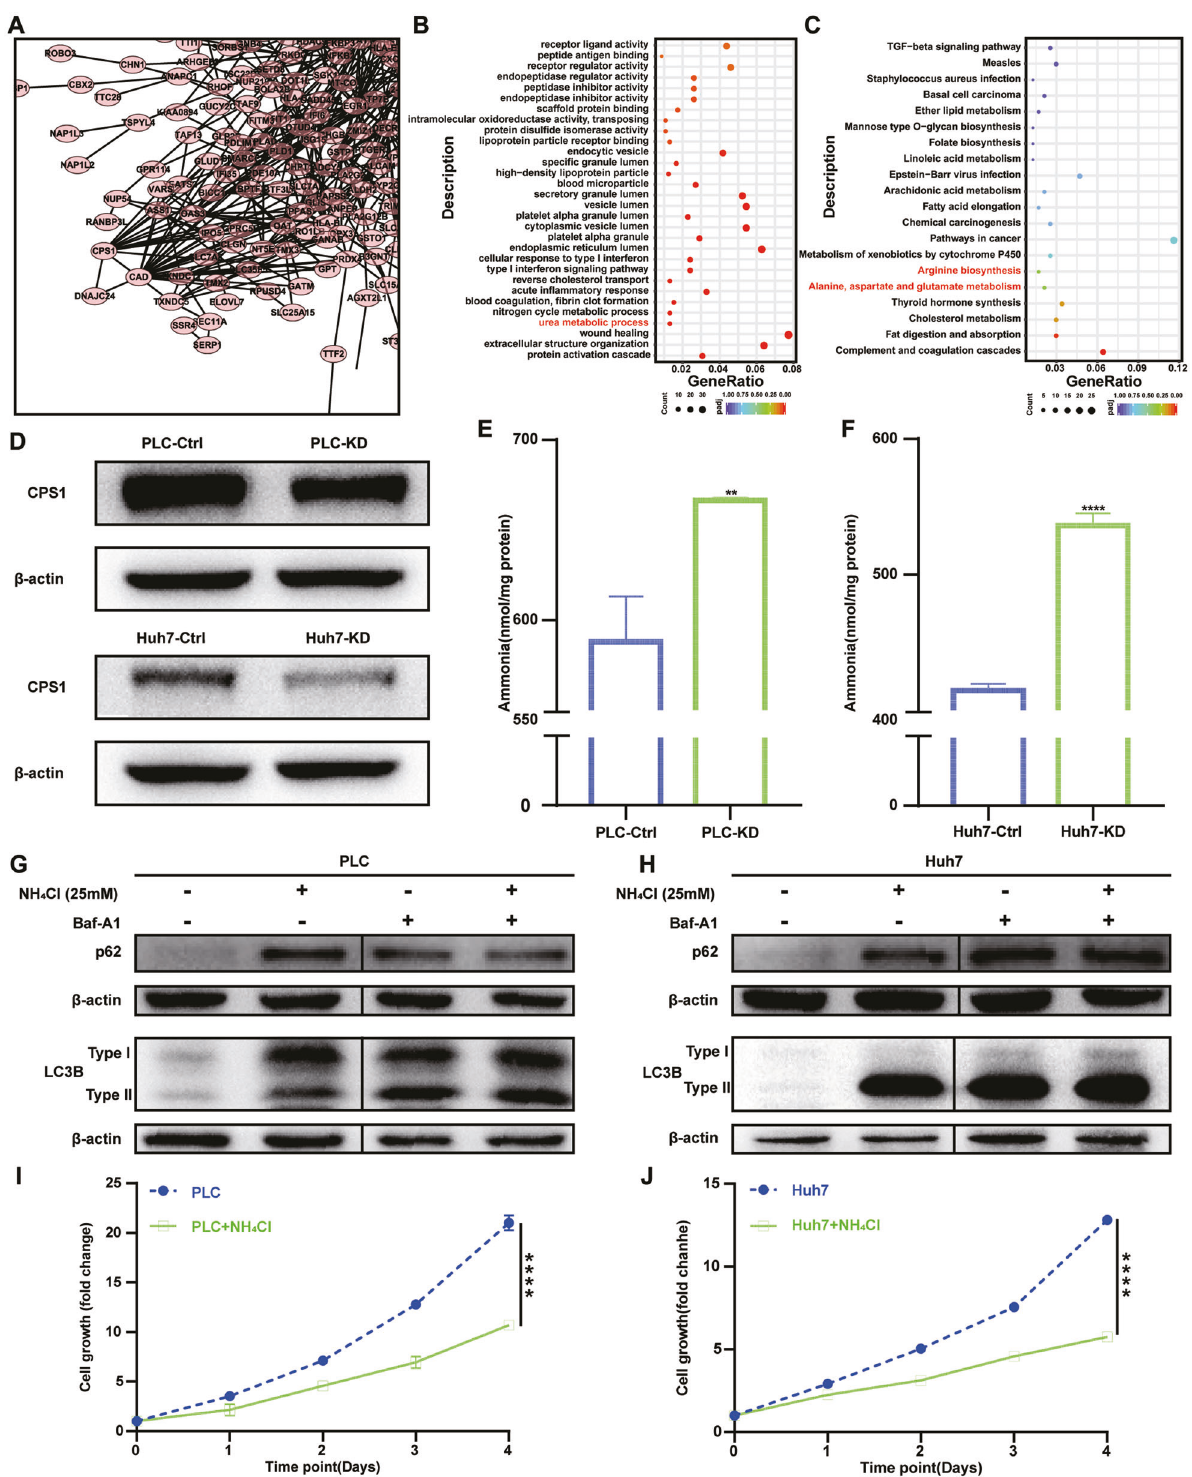
Fig. 6 DNAJC24 knockdown inhibits HCC cells proliferation and autophagy by affecting the metabolism of ammonia. A Interactions in the STRING protein interaction database were used to analyze DEGs interaction networks. B , C GO functional enrichment analysis ( B ) and KEGG pathway enrichment analysis ( C ) of DEGs was performed to identify functionally related gene pathways. D Western blotting was performed to determine protein levels of CPS1. E , F NH 4 + /NH 3 levels were measured in the PLC-KD ( E ) cells or Huh7-KD ( F ) cells as well as in the corresponding control cells using an ammonia assay kit by spectrophotometric analysis at 570 nm with extrapolation from the standard curve and expressed in nmol/mg protein. G , H NH 4 Cl ( fi nal concentration 25 mM) or/and Ba fi lomycin A1 ( fi nal concentration 400 nM) was added to the culture medium of PLC or Huh7 and incubated for 24h, respectively. Western blotting was performed to determine protein levels of LC3B. I , J CCK-8 cell viability assay analysis of the impact of NH 4 Cl ( fi nal concentration 25 mM) on PLC ( I ) and Huh7 ( J ) cell growth. Results were normalized to viability at day 0 and represented as fold change. Data were presented as mean ± SEM. n = 3 – 5. ** P < 0.01, **** P < 0.0001. Cell Death and Disease (2022)